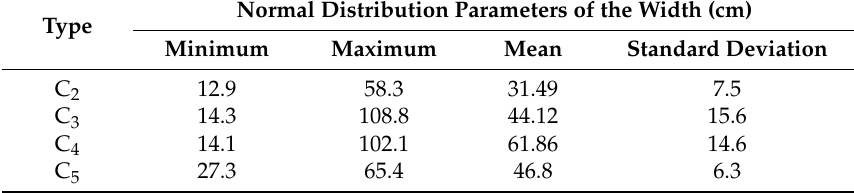
Table 2. The width distribution laws for partial ISWZs which are developed in the Baihetan dam